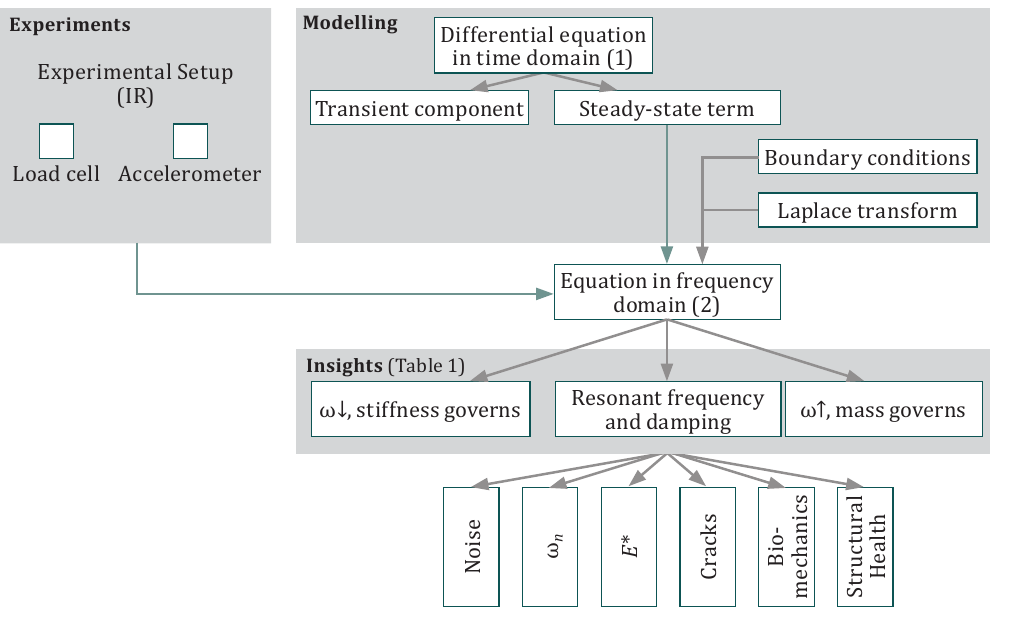
Figure 1. Model-based vs. experiment-based FRFs